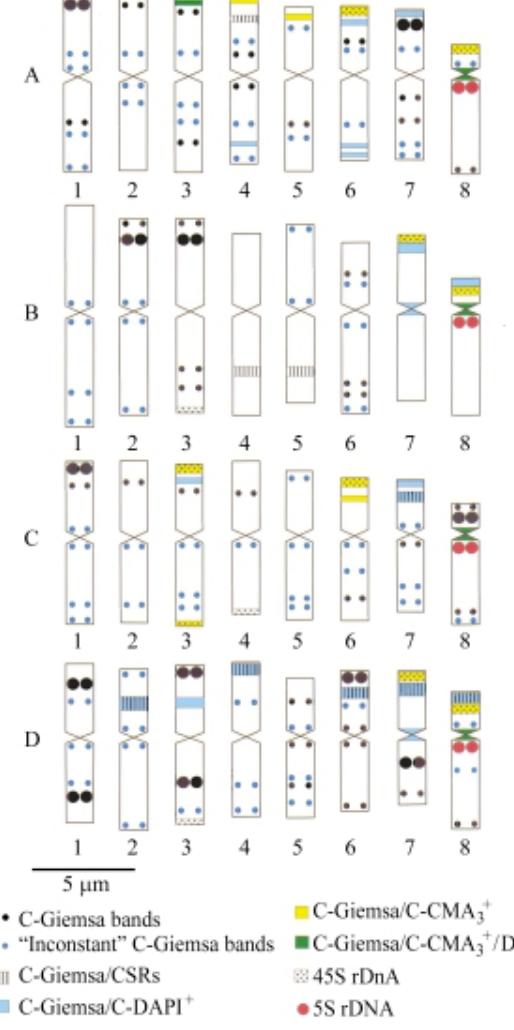
Figure 5 - Idiograms and chromosomal physical mapping of Cestrum amictum (A), C. intermedium (B), C. sendtnerianum (C) and C. strigilatum (D). The ‘inconstant’ bands correspond to small C-Giemsa + bands that were not detected in all the